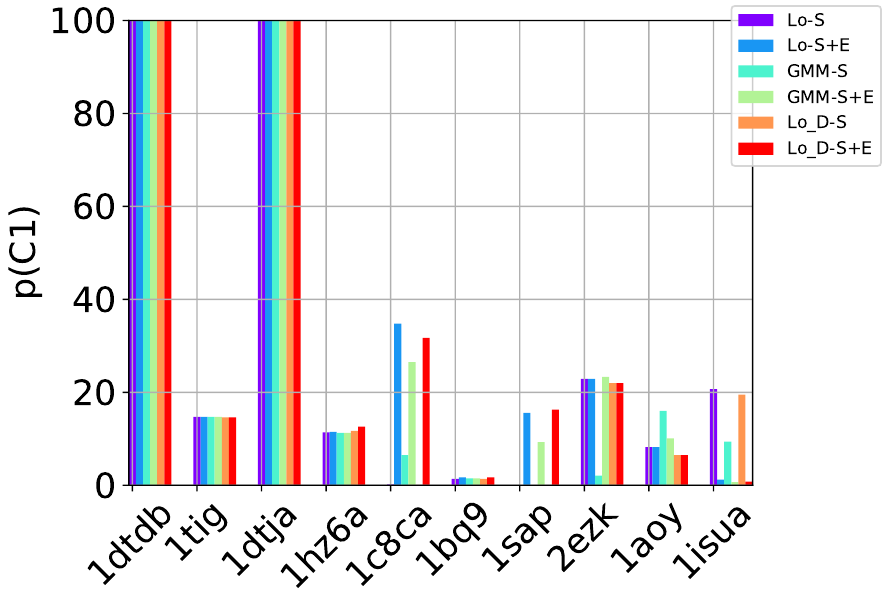
Figure 3. Comparison of community detection methods based on the quality of the top community selected by Sel-S and Sel-S+E. In the legend, Lo-D refers to the Louvain method applied to directed nngraphs that embed the decoy datasets. The -S and -S+E refer to the Sel-S and Sel-S+E selection strategies.